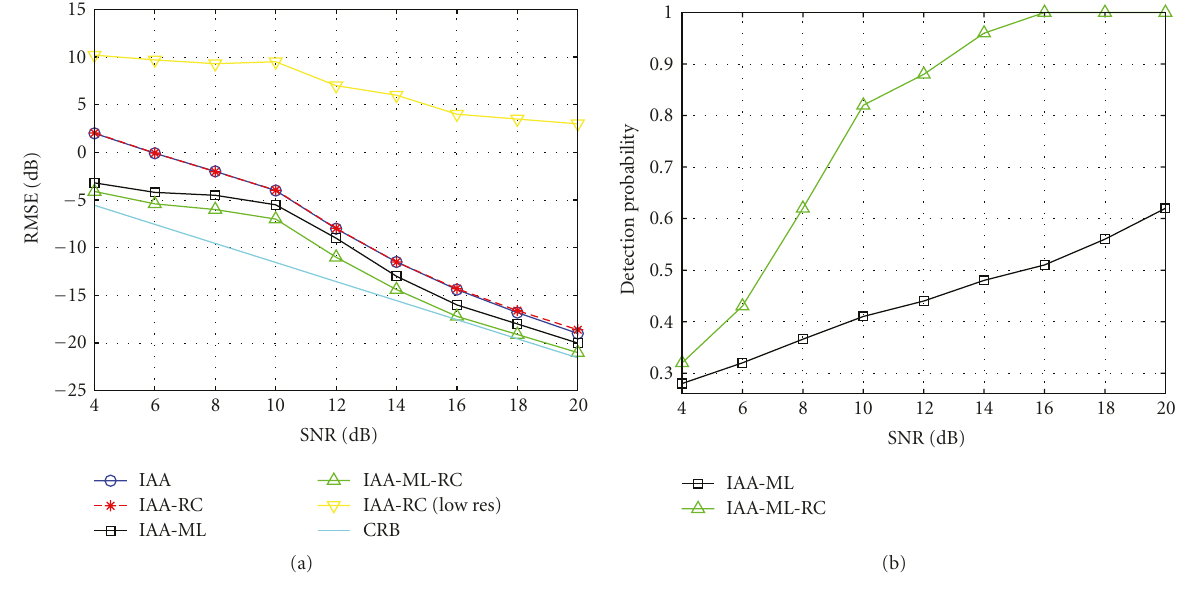
Figure 10: (a) RMSE of the di ff erent beamforming solutions. (b) IAA-ML versus IAA-ML-RC detection probability (rectangular array, θ 1 = 45 ◦ , φ 1 = 150 ◦ , θ 2 = 45 ◦ , φ 2 = 188 ◦ , θ 3 = 45 ◦ , φ 3 = 250 ◦ , N = 3 snapshots, noise power equal to 0dB, and f c =